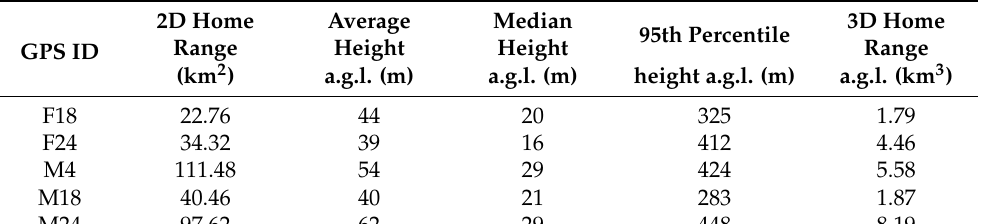
Table 3. For each lesser kestrel, the 2D and 3D properties of space use are shown. a.g.l. stands for ‘above ground level’. IDs are the same as those in Table 1.